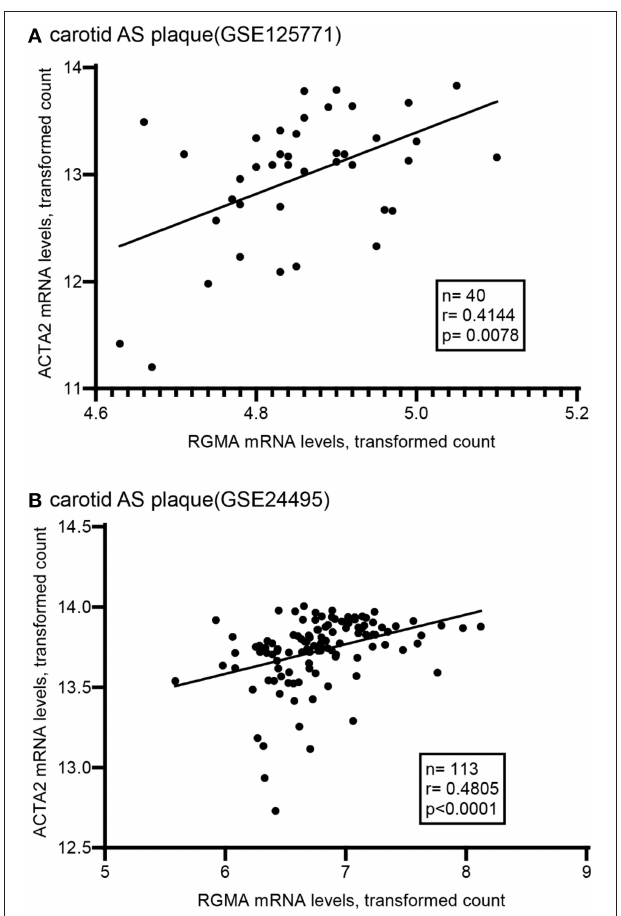
FIGURE 3 | The association of RGMA with ATCA2 in human carotid AS plaque. (A,B) RGMA mRNA transcription levels in carotid AS plaque positively correlated with ATCA2 mRNA levels in the two independent datasets from GEO database ( A according to GSE125771, B according to GSE24495). The correlation was tested by spearman’s rank test ( A : r = 0.4144, P = 0.0078; B : r = 0.4805, p <